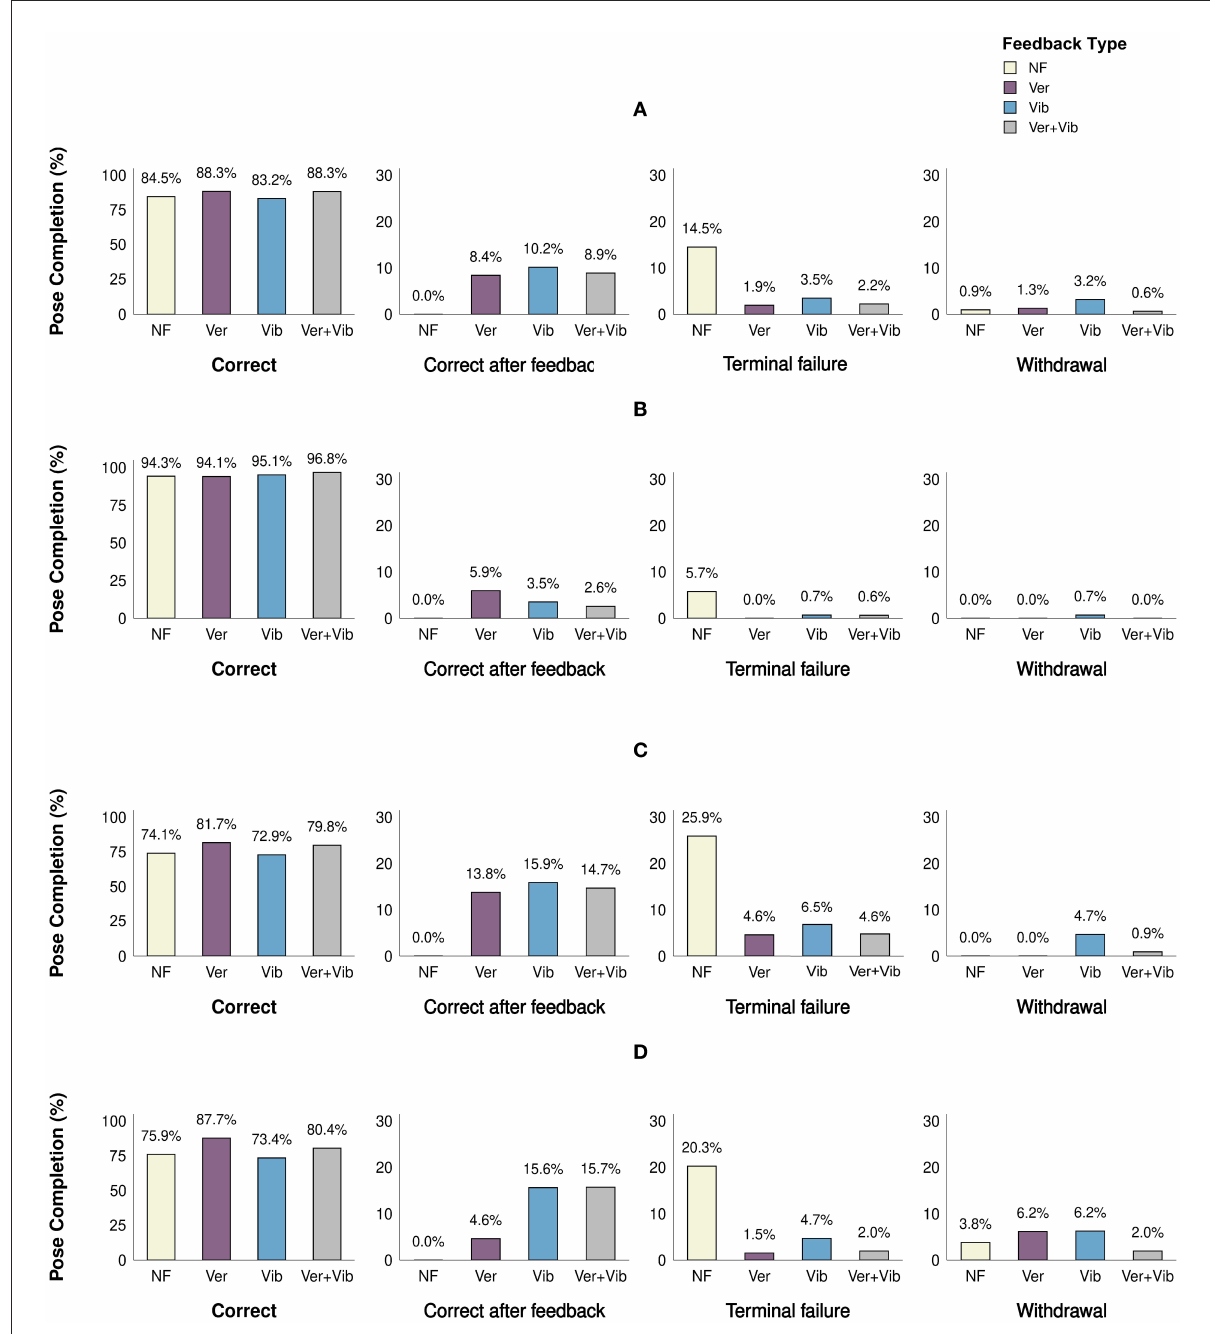
FIGURE5 Pose completion level (%) for different feedback types. Letters indicate significant pairwise differences at p < 0.05 within each pose completion level category within the bar chart. (A) Combined, (B) easy, (C) intermediate, and (D) difficult.